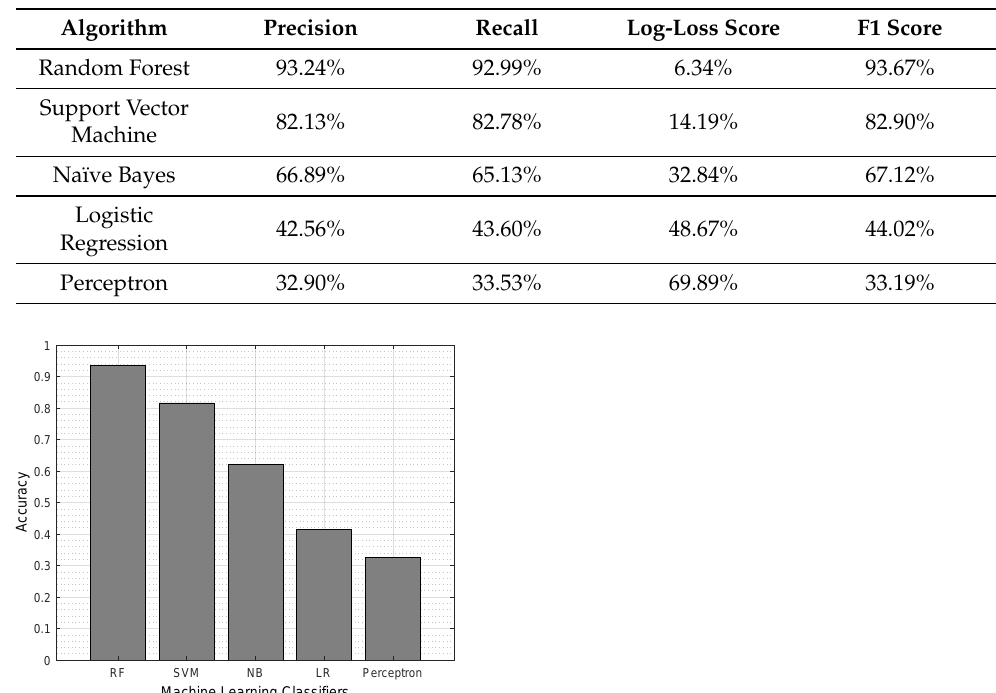
Table 5. Performance parameters of the proposed architecture.